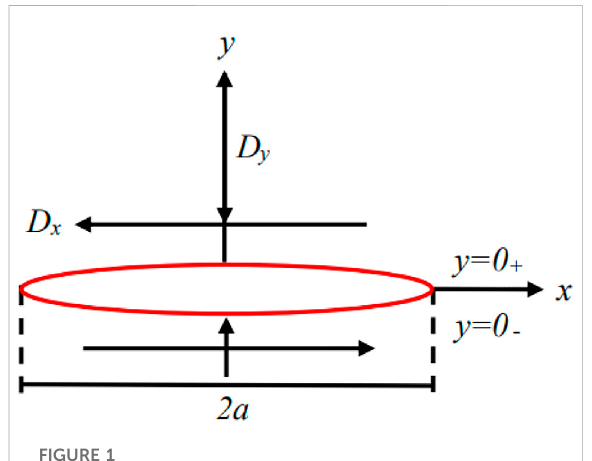
FIGURE 1 Discontinuity of constant displacement of fracture surface.